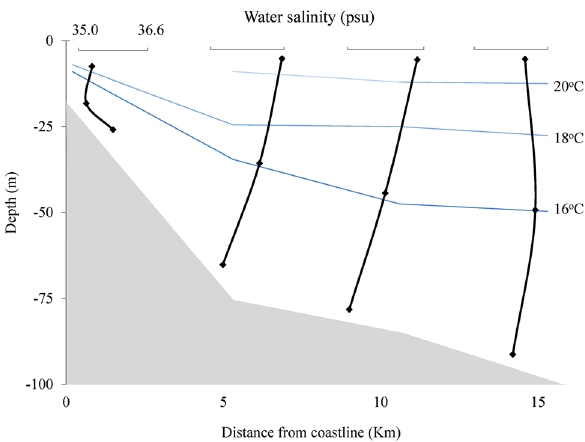
Figure 3. Salinity of the longitudinal samples from the surface, middle, and bottom of the water column.